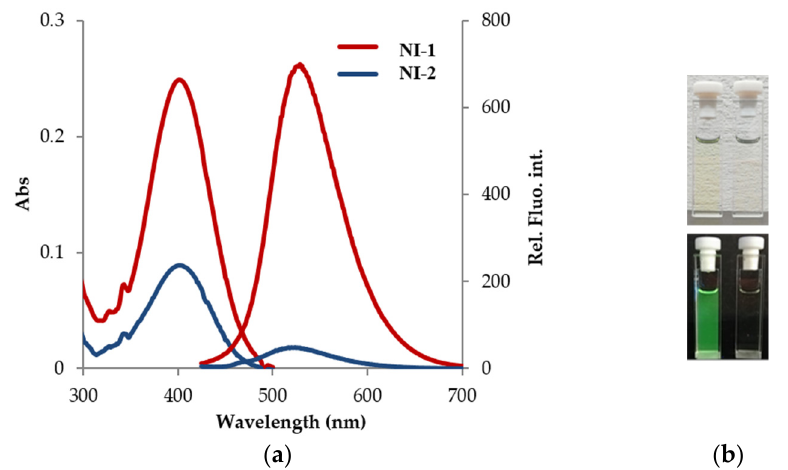
Figure 2. ( a ) UV-Vis absorption and fluorescence emission spectra of NI-1 and NI-2 solutions in methanol ( c = 1.0 × 10 − 5 M, λ exc = 410 nm); ( b ) Images of solutions in daylight (above) and under UV lamp (365 nm)